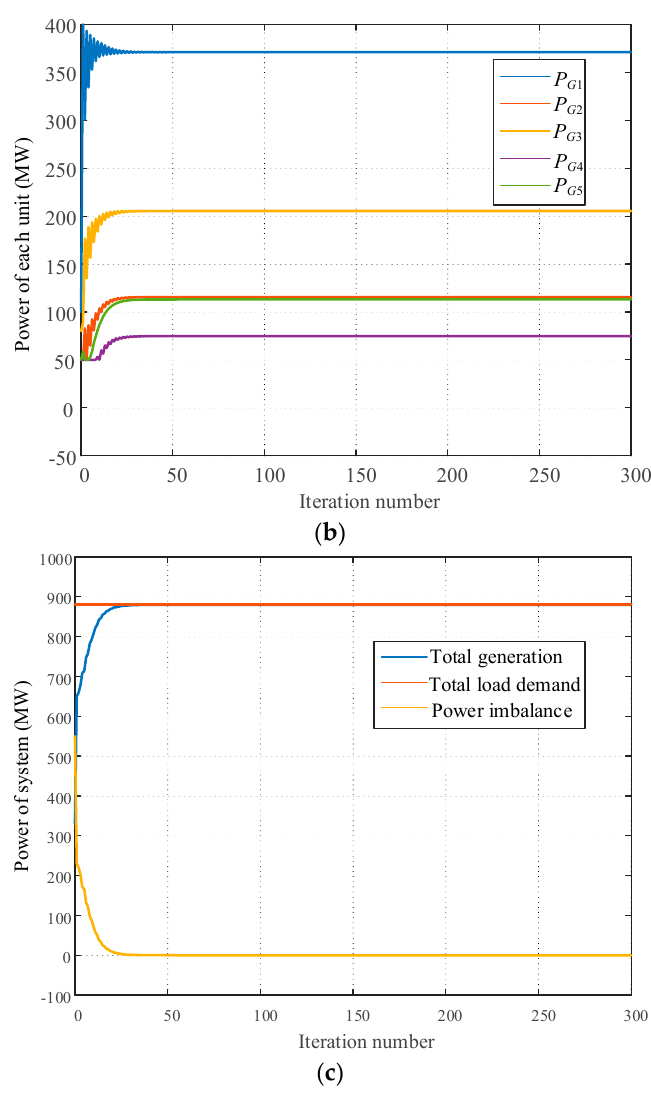
Figure 5. Simulation results by using the distributed ED strategy in reference [30]. ( a ) Incremental cost; ( b ) power of each unit; ( c ) power information of the system.